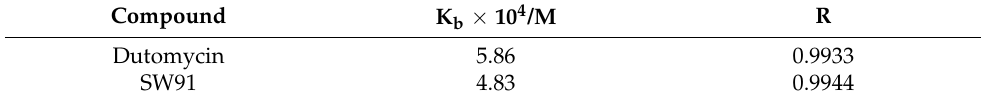
Table 2. Binding constant K b values of compounds dutomycin and SW91 interacting with CT-DNA.